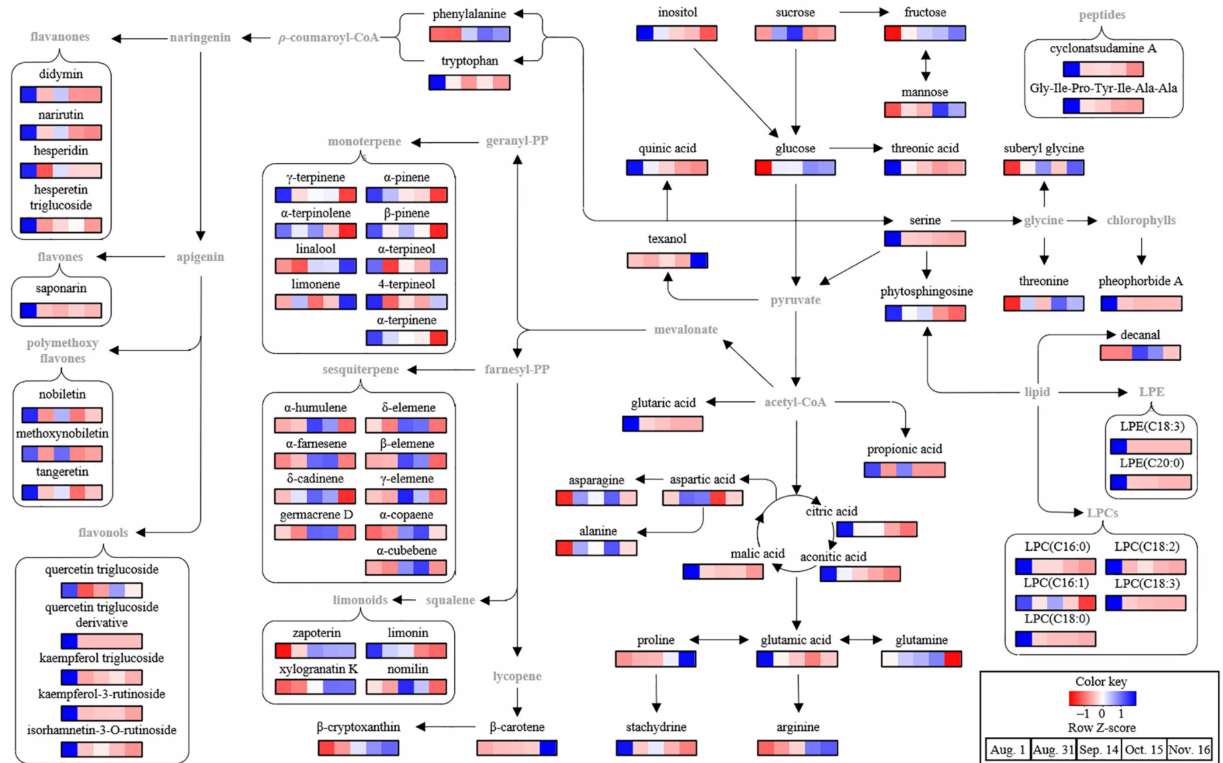
Figure 4. Schematic diagram of the metabolomic pathway associated with the fruit development of Citrus unshiu . The metabolomic pathway was retrieved from the KEGG database (https://www.kegg. jp/ (accessed on 17 January 2022)) and drawn with some modifications. The heat maps drawn by R software with ggplot2 showed the relative abundance of identified metabolites. The heat map colors represent the z-score transformed raw data of metabolites with the significant differences among groups. Blue and red indicate the increase and decrease in metabolite levels,